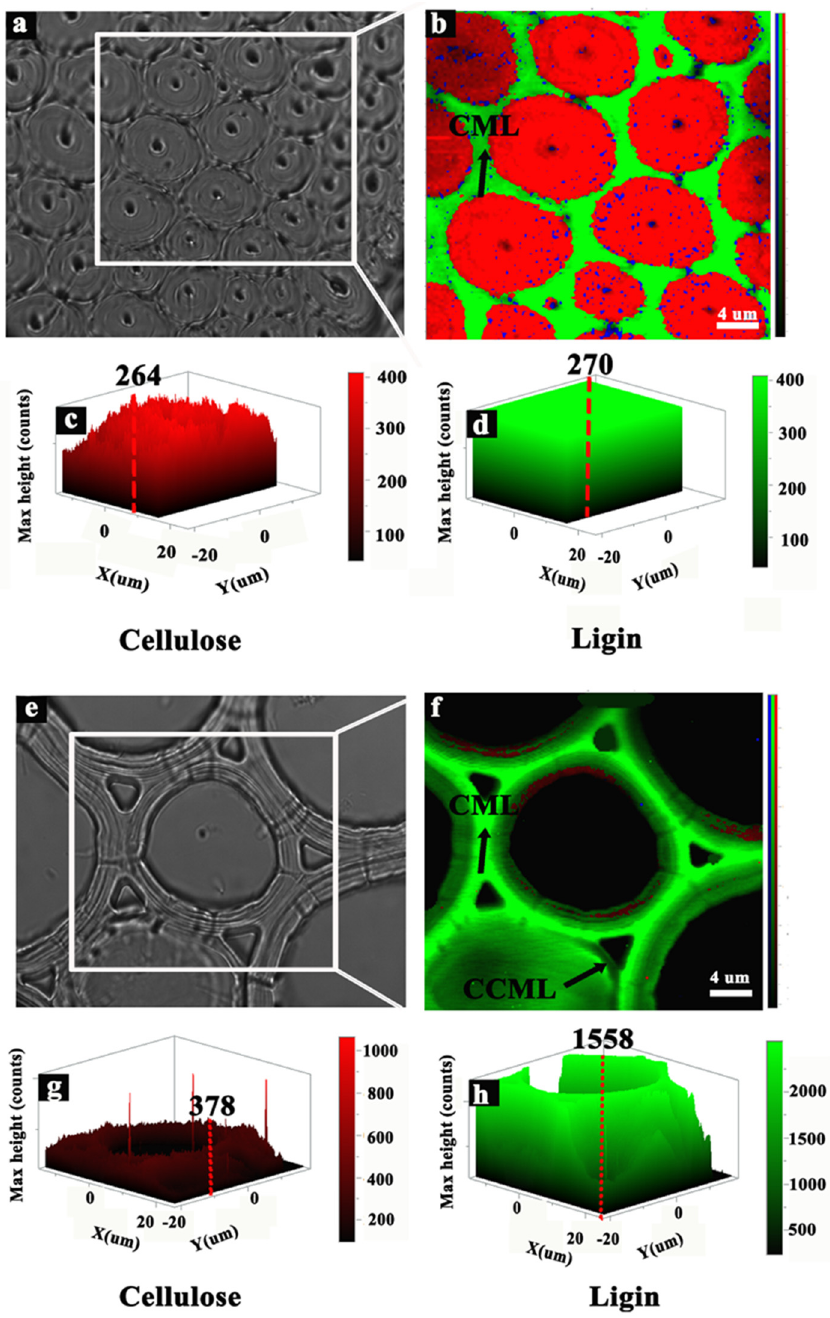
Figure 5 . Raman spectra of a fiber cell and a parenchyma cell. ( a , b ) Raman image of the cellulose and lignin contents of a fiber cell. ( c , d ) Chemical components of the fiber cell and the compound middle lamella (CML). ( e , f ) Raman images of the parenchymal cell. ( g , h ) Chemical components of the parenchymal cell.